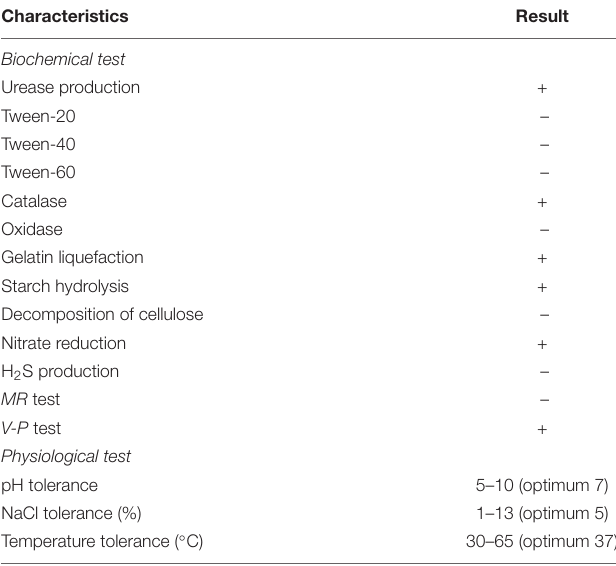
TABLE 1 | Physiological and biochemical characteristics of strain QN1NO-4.